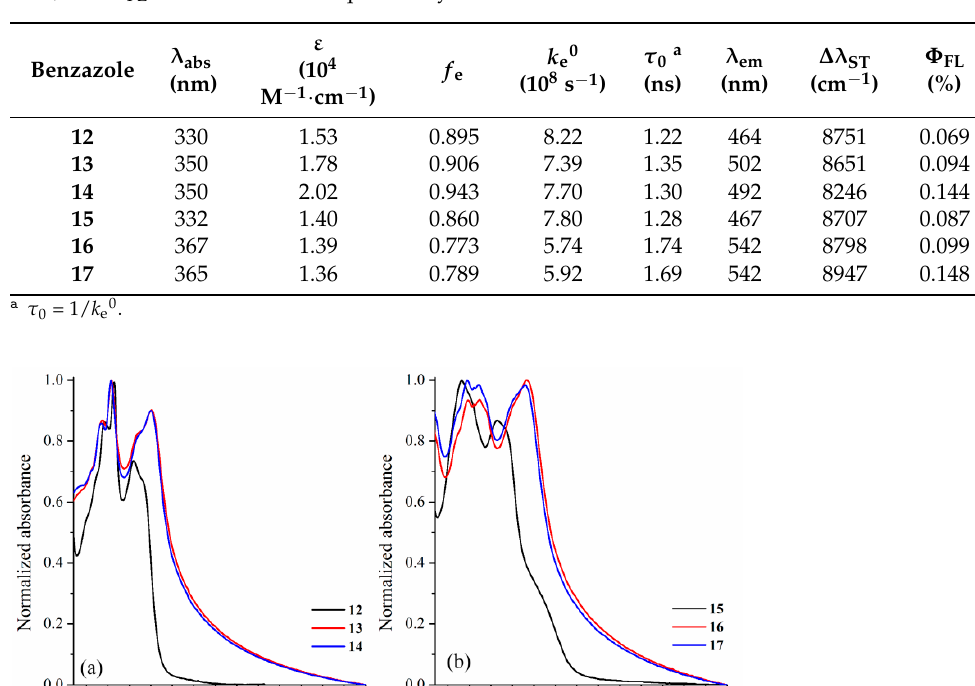
Table 1. Photophysical data of ESIPT fluorescent lipophilic benzoxazoles 12 – 17 from UV-Vis absorption and fluorescence emission spectroscopies, where ε is the molar extinction coefficient, λ abs and λ em are the absorption and emission maxima, respectively, f e is the calculated oscillator strength, k e 0 is the calculated radiative rate constant, τ 0 is the calculated pure radiative lifetime, Δ λ ST is the Stokes shift, and Φ FL is the fluorescence quantum yield.